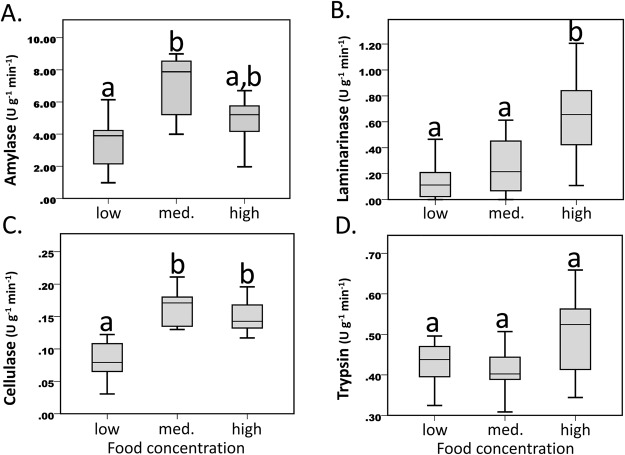
Laboratory digestive enzyme activities. Digestive enzyme activity of (A) amylase, (B) laminarinase, (C) cellulase, and (D) trypsin, under laboratory treatments (low, medium and high). Box plots reveal the lower and upper quartiles (box), and the median (line within the box). The adjacent values mark the smallest and largest values not declared as outliers. A one-way ANOVA followed by Tukey's test was used to identify significant differences in mean digestive enzyme activities between treatment groups. The letters indicate the association between treatment groups.